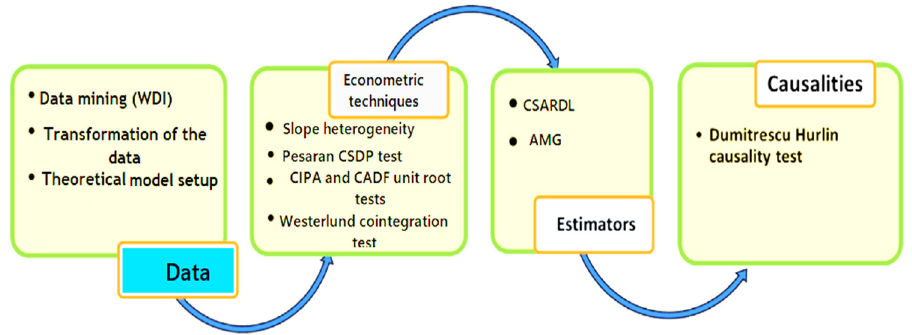
Figure 3. Methodological process.